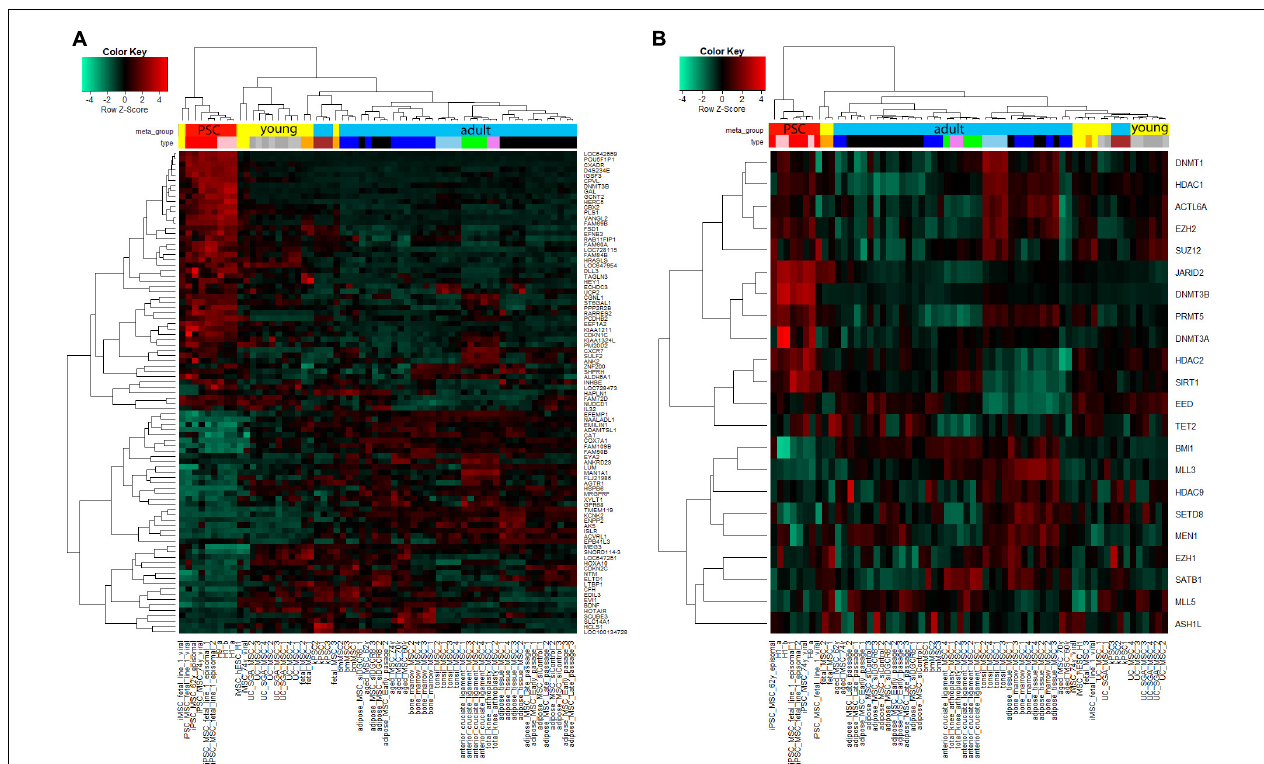
FIGURE 6 | Cluster analysis displays agglomeration of young (iMSCs, fetal, and UC-MSCs) MSCs in epigenetics-related gene signatures. (A) Heatmap using the aged-rejuvenation gene signature from our previous publication (Spitzhorn et al., 2017) yields coherent clusters of PSCs and iMSCs with fetal and